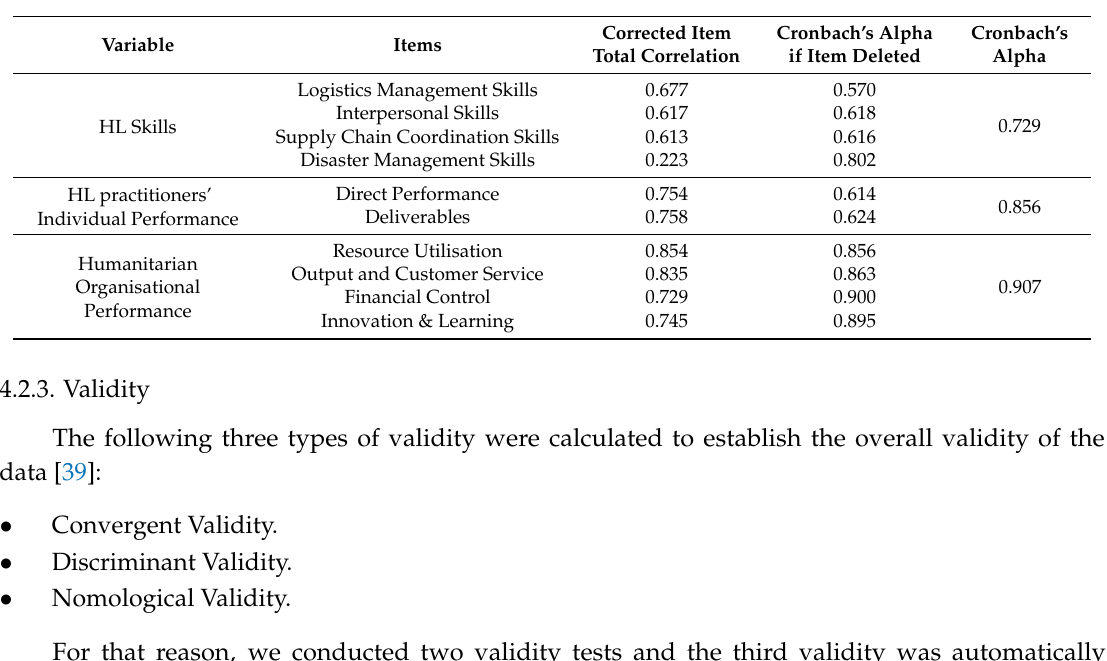
Table 6. Cronbach’s alpha reliability of latent variables (Source: Survey data).